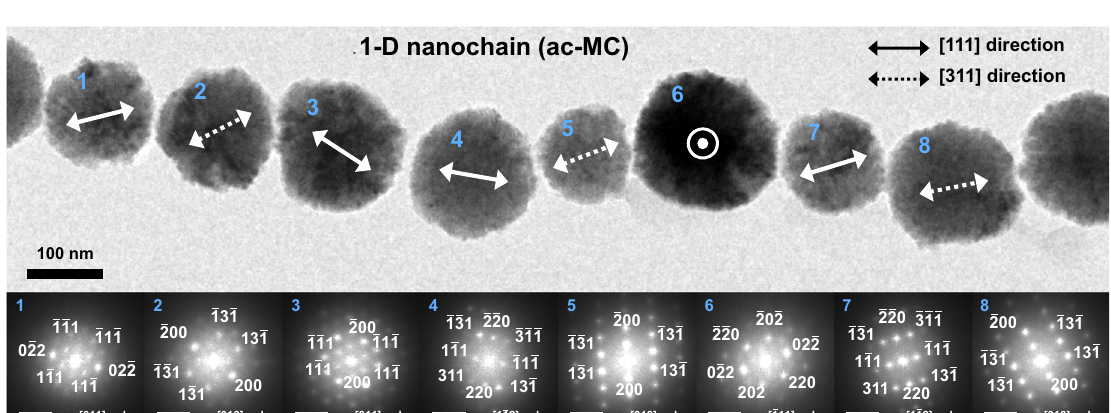
Fig. 6 Magnetic properties of mesocrystals and their 1-D nanochains depending on the BNC alignment. a Zero- fi eld-cooling (ZFC)/ fi eld-cooling (FC) magnetisation curves. b H c plot of Fe 3 O 4 mesocrystals depending on the crystallographic order in BNC alignment. c H c behaviour of the nanochains as a function of the angle θ between the axial directions of the nanochains and the direction of the applied magnetic fi eld. Each point is the average of three different measurements; the error bars denote the standard deviations. d Effects of inter-BNC magnetic interactions on the magnetic behaviour of mesocrystals and their nanochains. Single arrows indicate the local magnetocrystalline anisotropy. e BF-TEM image of a 1-D nanochain composed of Fe 3 O 4 mesocrystals with aligned BNCs (ac-MCs). The ac-MCs are arranged in the direction of the magnetic fi eld (160 kA m − 1 ). The solid and dotted double arrows indicate the [111] and [311] directions of the Fe 3 O 4 unit crystal derived from the FFT analysis. The scale bars in the FFT images represent 5 nm – 1